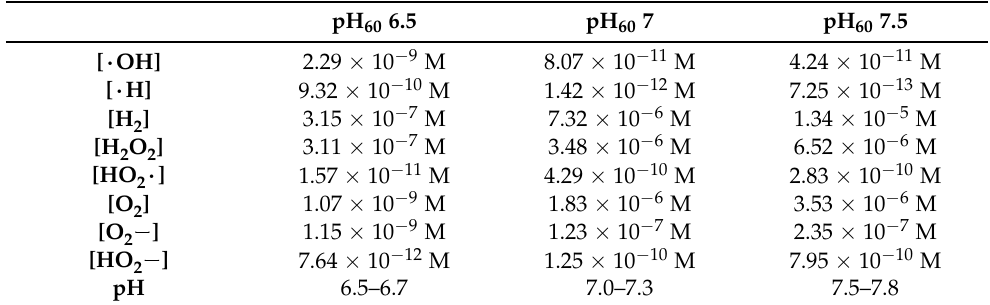
Table 4. Concentrations of main species after 1 year of constant radiation at pH 60 6.5, 7, and 7.5.